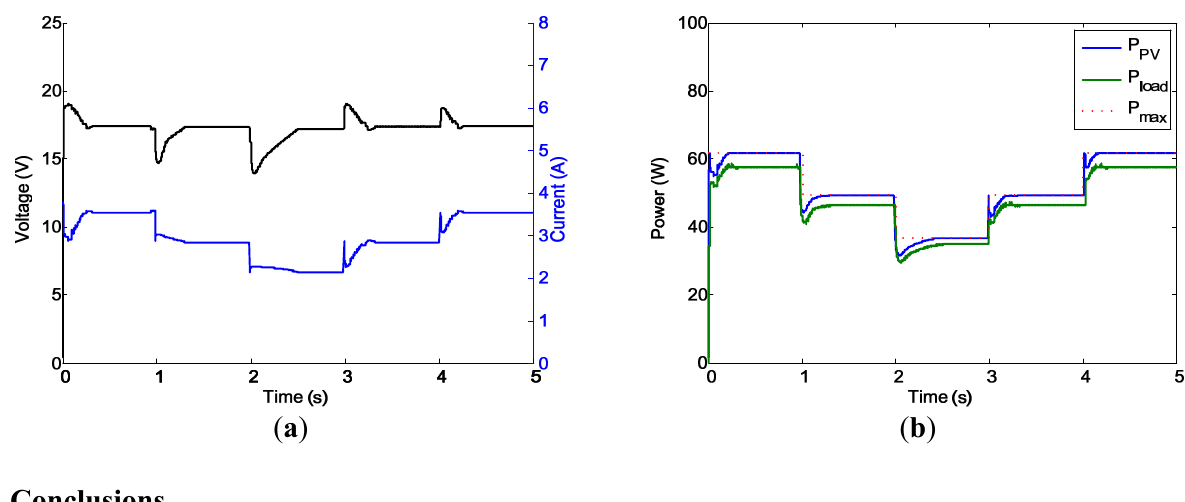
Figure 20. Circuit simulation for irradiation variations using four-switch type converter. ( a ) Voltage and current from PV model; ( b ) Power output from PV model and power at the load